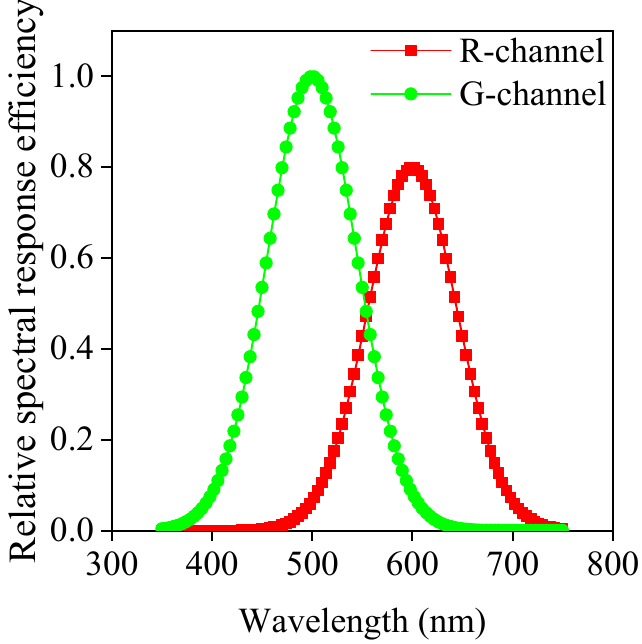
Figure 4. Relative spectral-response efficiency functions of the R and G channels, simulated by using the Gaussian function.